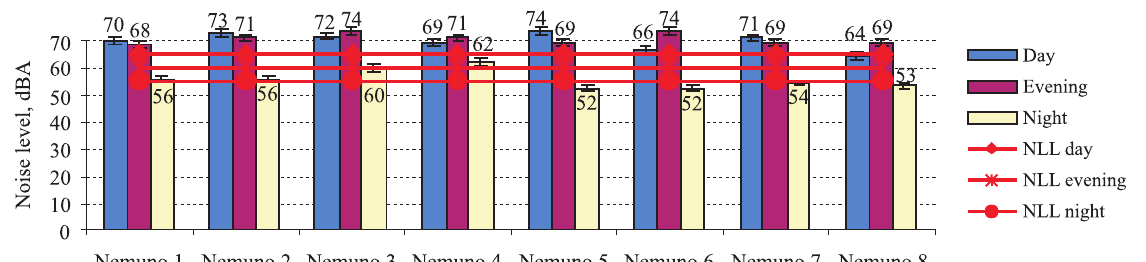
Fig. 2. The changes of equivalent noise levels in Nemunas street (NLL – noise level limit)